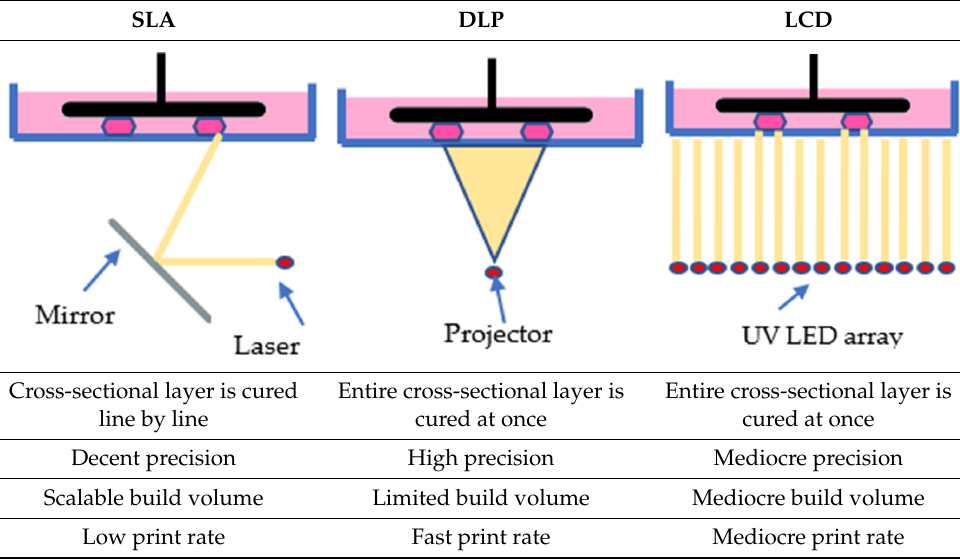
Table 1. Schematic diagrams and characteristics of different vat polymerization techniques. SLA DLP LCD